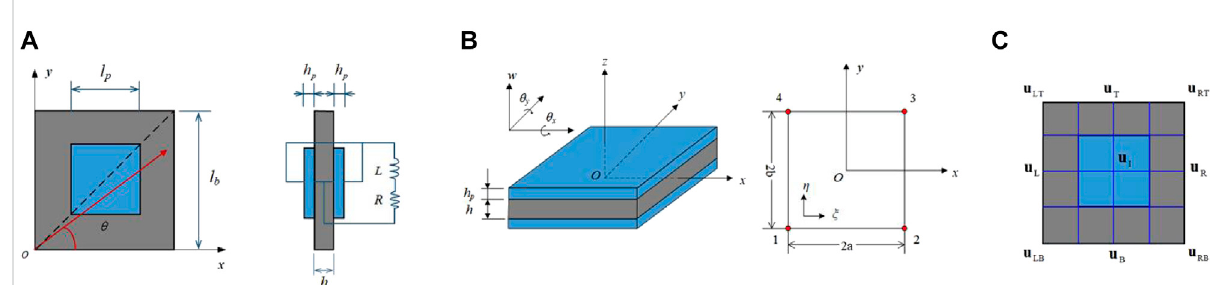
FIGURE 1 (A) The square unit cell; (B) Composite plate structure and rectangular element in x-y plane; (C) A typical mesh arrangement for the domain